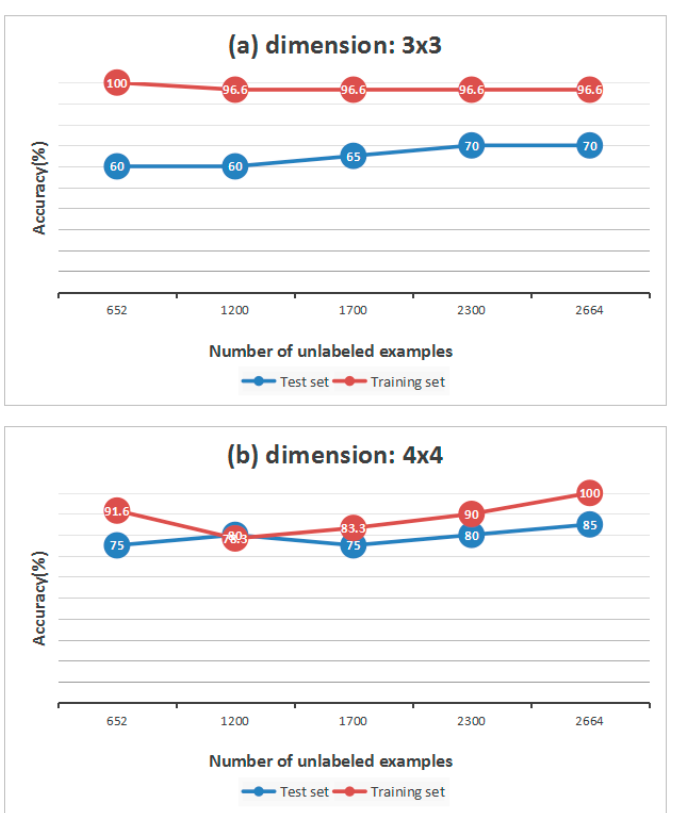
Figure 8. Accuracy with different number of unlabeled samples. ( a ) shows the change of accuracy as the number of examples increases when dimension is 3 × 3; ( b ) shows the change of accuracy as the number of examples increases when dimension is 4 × 4.